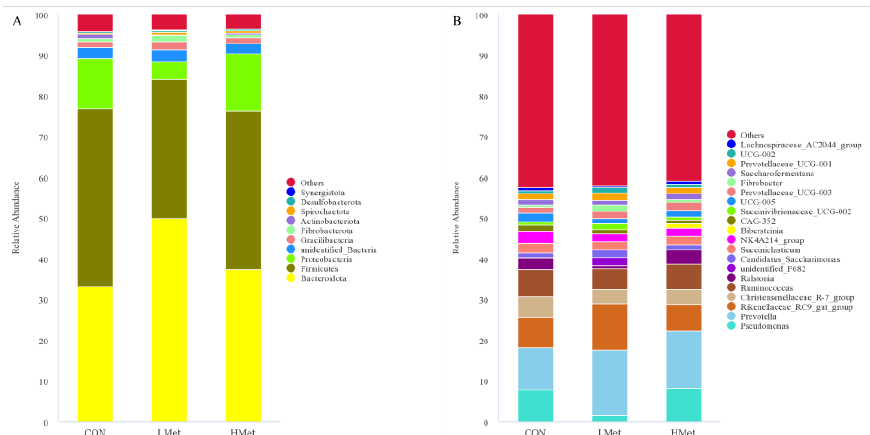
Figure 1. Bacterial composition in the rumen of sika deer at the phylum ( A ) and genus ( B ) levels.